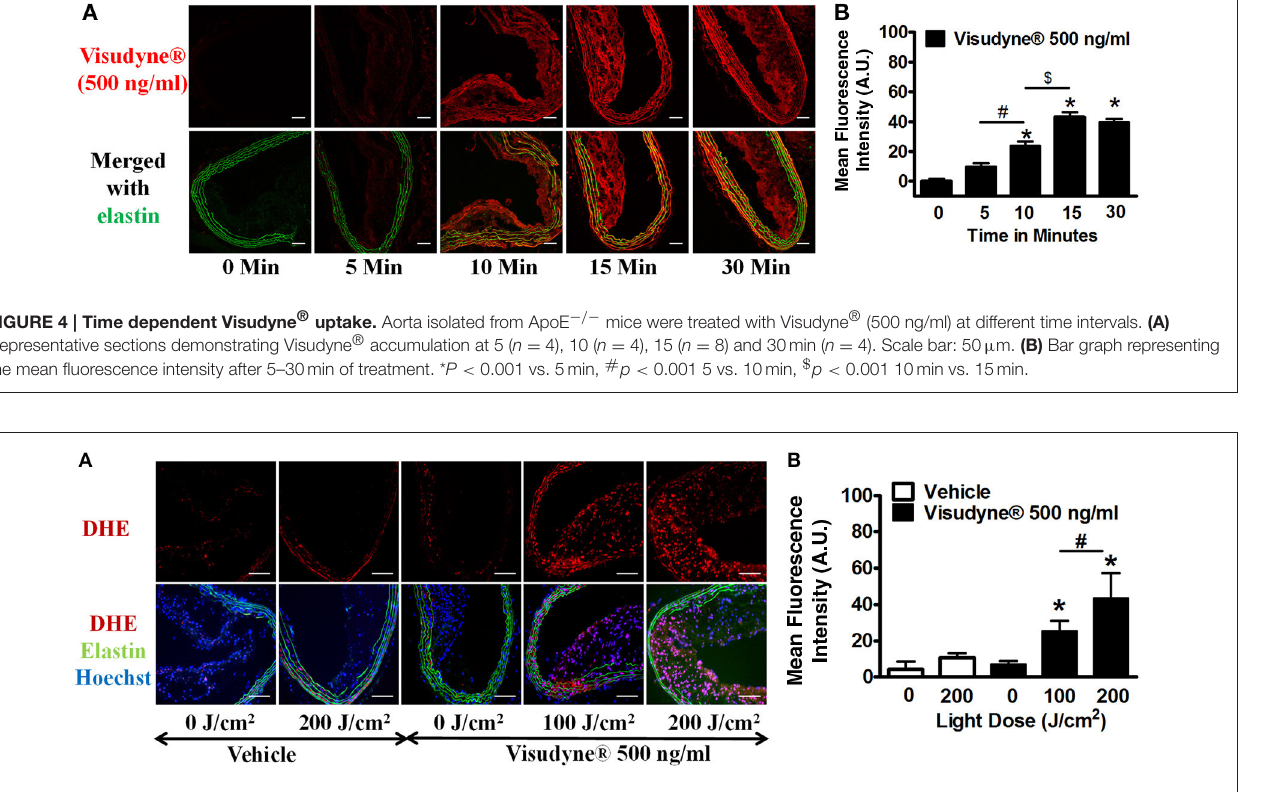
FIGURE 5 | ROS production by Visudyne ® mediated PDT. (A) Fluorescent photomicrograph of Dihydroethidium staining in aortic sections from vehicle ( n = 6), laser only ( n = 4), Visudyne ® only ( n = 4), Visudyne ® treated, laser (100J/cm 2 ; n = 6) or Visudyne ® treated, laser (200J/cm 2 ; n = 6) treated groups. Upper panel shows ROS signals as red fluorescence and lower panel represents the merged image with green elastin auto fluorescence together with blue fluorescence of the Hoechst stained nuclei. Scale bar: 100 µ m. (B) Bar diagram representing DHE fluorescence intensity/ µ m 2 . * P < 0.05 vs. 0J/cm 2 , # p < 0.01 100 vs. 200J/cm 2 .